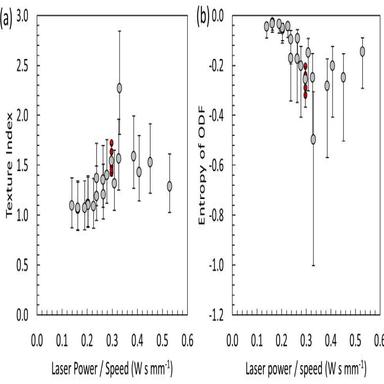
(a) Texture index versus the ratio of laser power over scan speed. A texture index of 1 indicates a uniform distribution or no texture. (b) Entropy of the orientation distribution function (ODF). An entropy of 0 indicates a uniform distribution or no texture. See for a description of the interval calculations. Smaller, red data points are the five columns at the default settings. (For interpretation of the references to color in this figure legend, the reader is referred to the web version of th